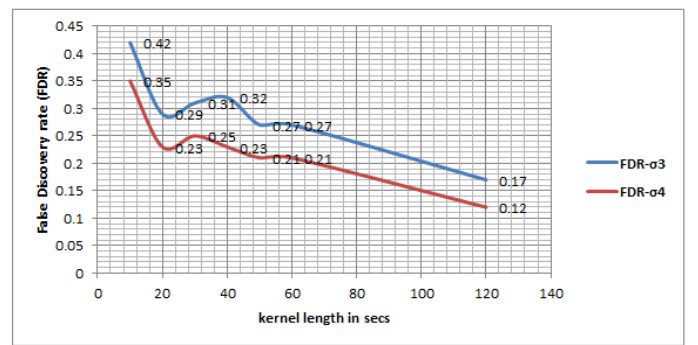
Figure 11. False discovery rate (FDR) of a RF based classifier for trip detection at different ς using a state based bottom up approach.